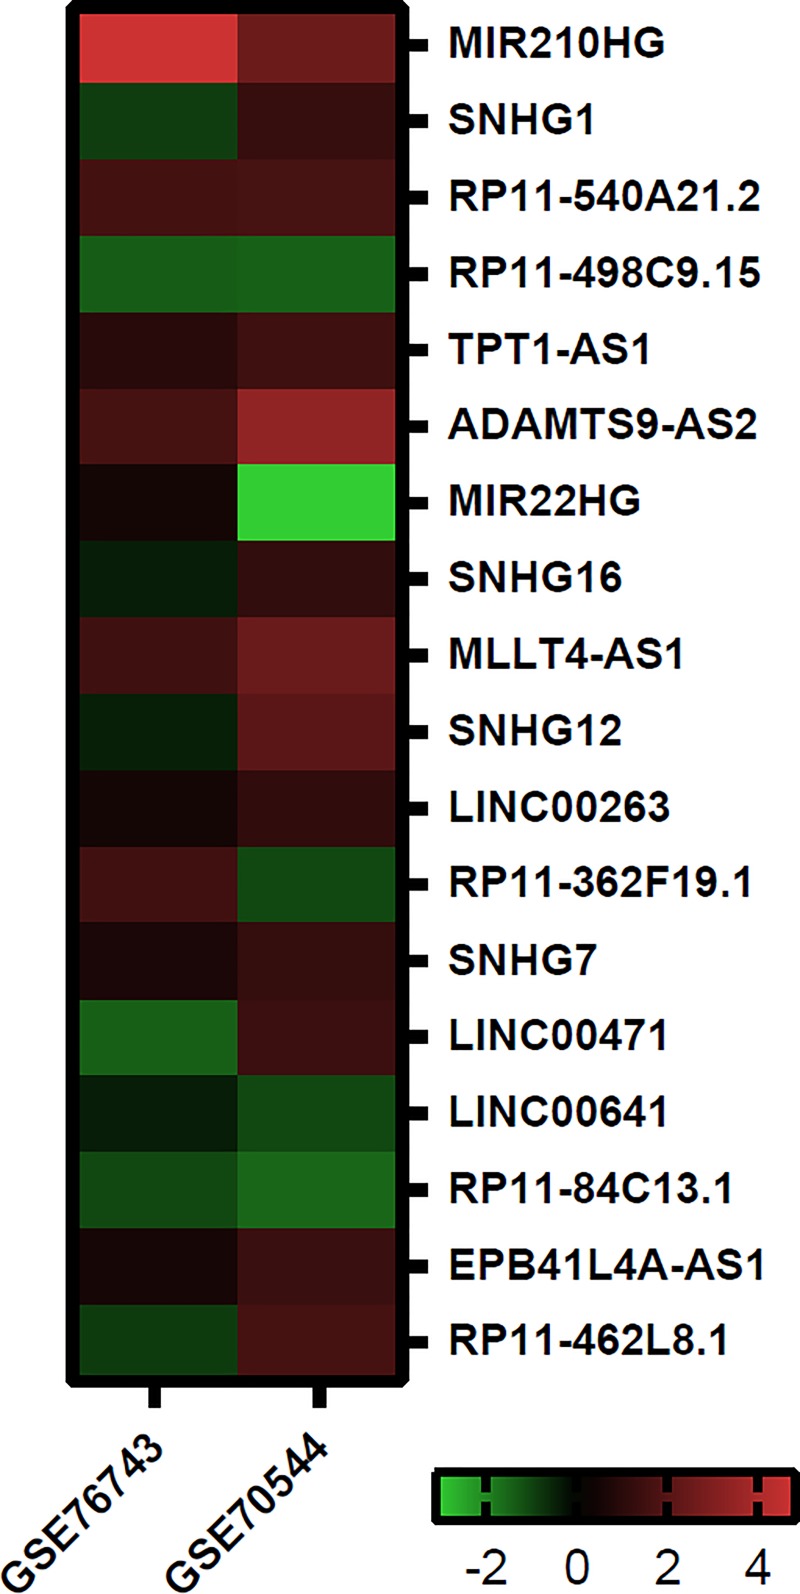
Heat maps of overlapping differentially expressed long non-coding RNA (lncRNA) responding to hypoxia in two Gene Expression Omnibus (GEO) datasets.